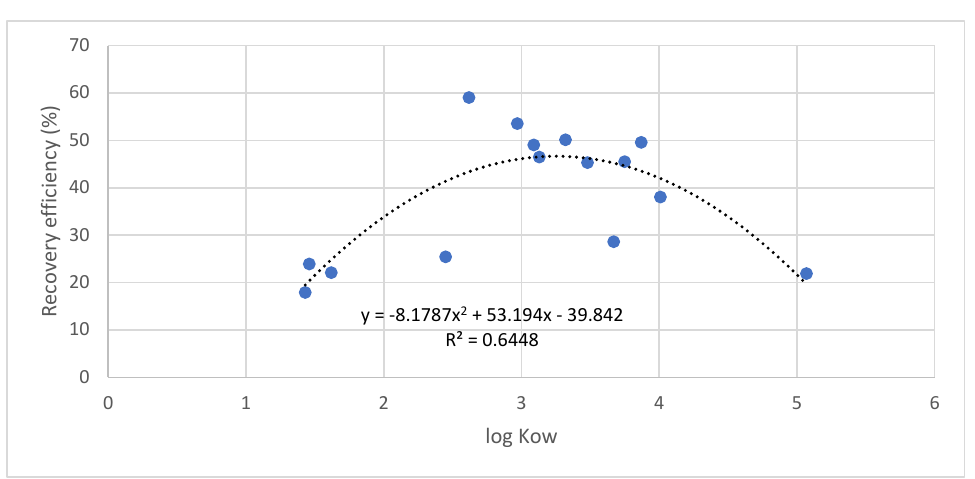
Figure 3. Relationship between experimental recovery efficiencies and the octanol–water partition coefficient.